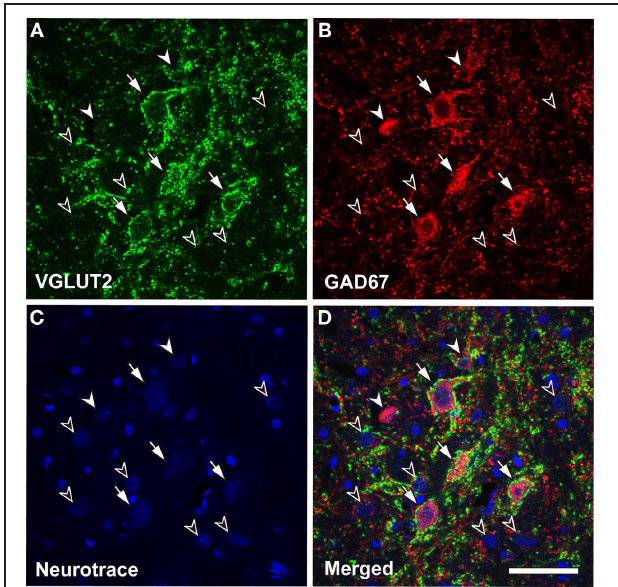
FIGURE 1 | Glutamatergic axosomatic terminals on large GABAegic (LG) neurons. VGLUT2-immunopositive terminals ( A , green) make dense axodendritic and axosomatic contacts ( A – D , arrows) on GAD67-immunopositive ( B , red) LG neurons. Smaller GAD67-positive neurons ( A – D , SG, white arrowheads) and GAD67-negative cells ( A – D , black arrowheads) do not receive VGLUT2 axosomatic terminals. Neurotrace Nissl Stain (blue) is shown in C . Bar: 50 μ m.